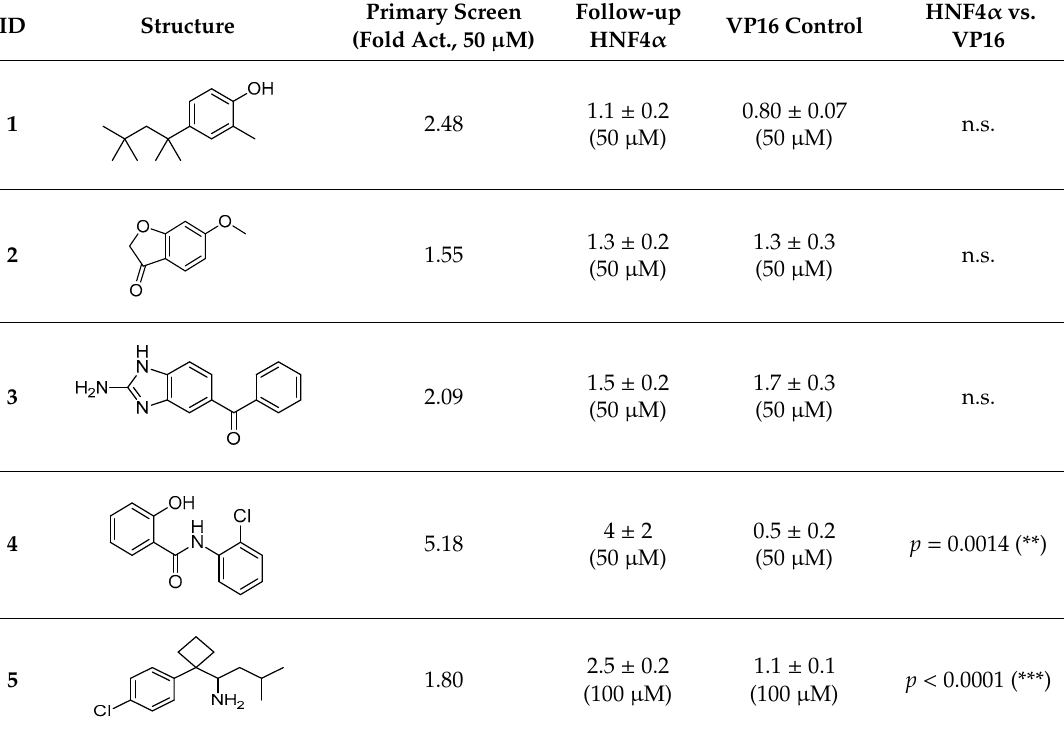
Figure 2. Activity distribution and primary hits in the fragment screening. Red line shows the mean, dotted red lines show mean ± SD. Each point represents the activity of one fragment at 50 µM expressed as mean fold activation vs. 0.2% DMSO from two biologically independent repeats. Green crosses refer to HNF4 α agonist candidates, yellow crosses refer to inverse HNF4 α agonist candidates, blue dots represent fragments without activity on Gal4-HNF4 α . Table 1. Primary screening hits with primary screening data and control experiment on VP16 for non- specific activity. Primary screening data are the mean of two biologically independent repeats. HNF4 α follow-up data and VP16 control data are the mean ± SD fold activation of reporter activity of at least four biologically independent repeats in duplicates. n.s. - not significant ( p ≥ 0.05), ** p < 0.01, *** p < 0.001 ( t -test).